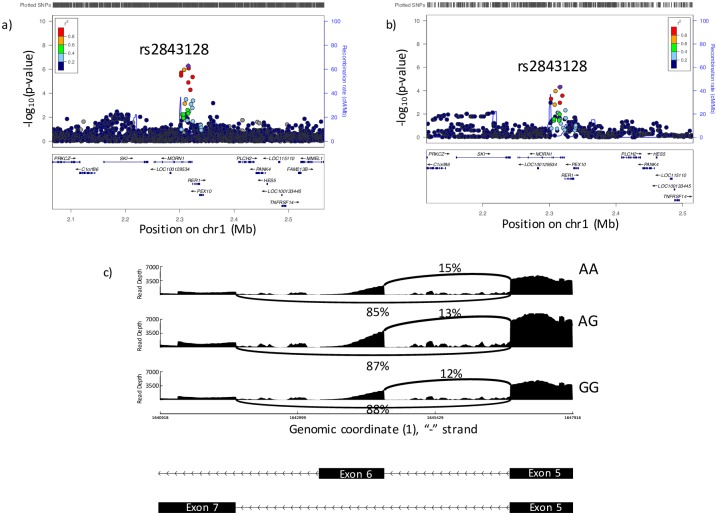
Colocalization analysis of sQTLs and COPD GWAS data at 1p36.32.a) Locus zoom plot of the GWAS association at 1p36.32. b) Locus zoom plot of sQTL data for the association between CDK11A splicing with genotype. c) Visualization of the CDK11A splice site associated with rs2843128. The y axis shows read depth and the x axis shows genomic position on chromosome 1. Arched lines indicate junction spanning reads.